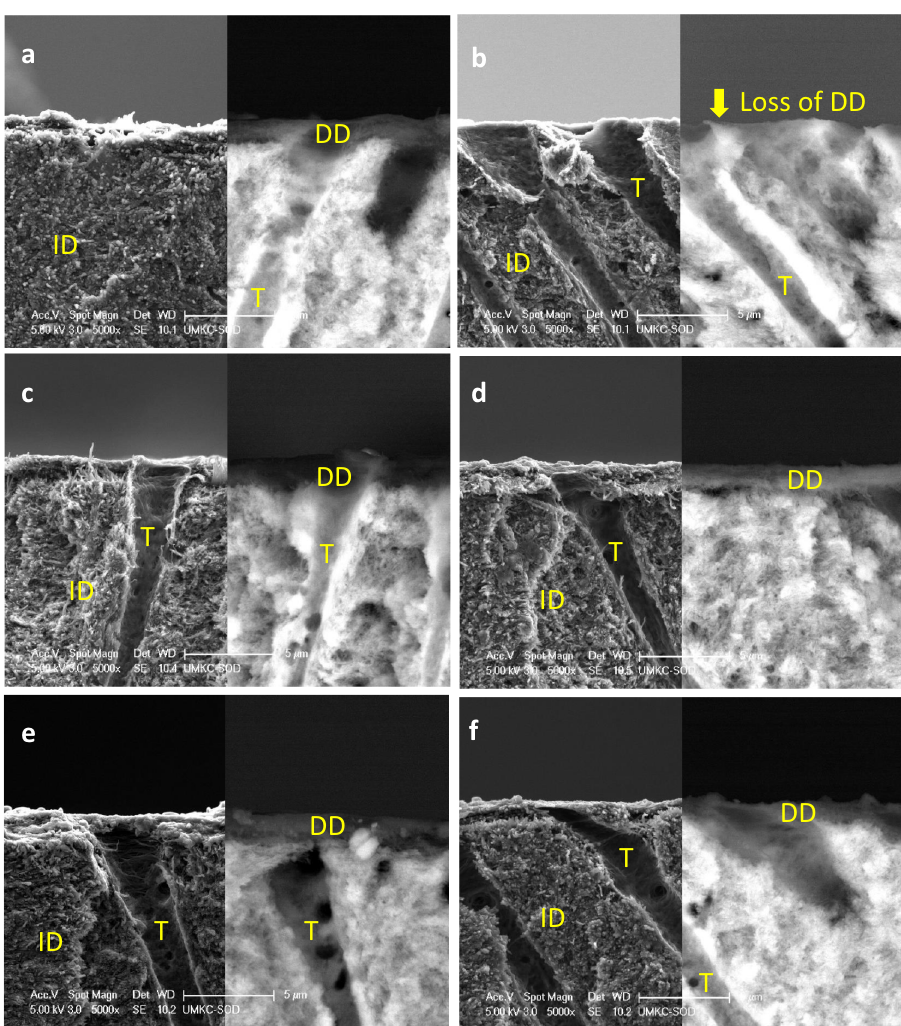
Figure 4. Secondary-electron (SE, left) and back-scattered electron (BSE, right) SEM images of acid-etched dentin without treatment ( a ) before and ( b ) after digestion (in 0.1% collagenase at 37 °C for 1 h); treated with 2.0% TF for 30 s followed by digestion ( c ); treated with 2.0% PA for 30 s followed by digestion ( d ); treated with 0.4% TF for 30 s followed by digestion ( e ); and treated with 0.4% PA for 30 s followed by digestion ( f ). The demineralized dentin layer of untreated control was evident as dark layer atop intact dentin under BSE mode before digestion ( a ), and was completely lost after digestion ( b ), while that of all treated groups ( c – f ) remained after digestion. DD demineralized dentin. ID intact dentin. T